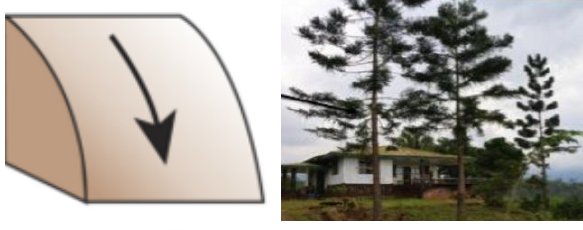
Figure 15. Negative profile curvature (left) and a Pinus carribaea species (right)